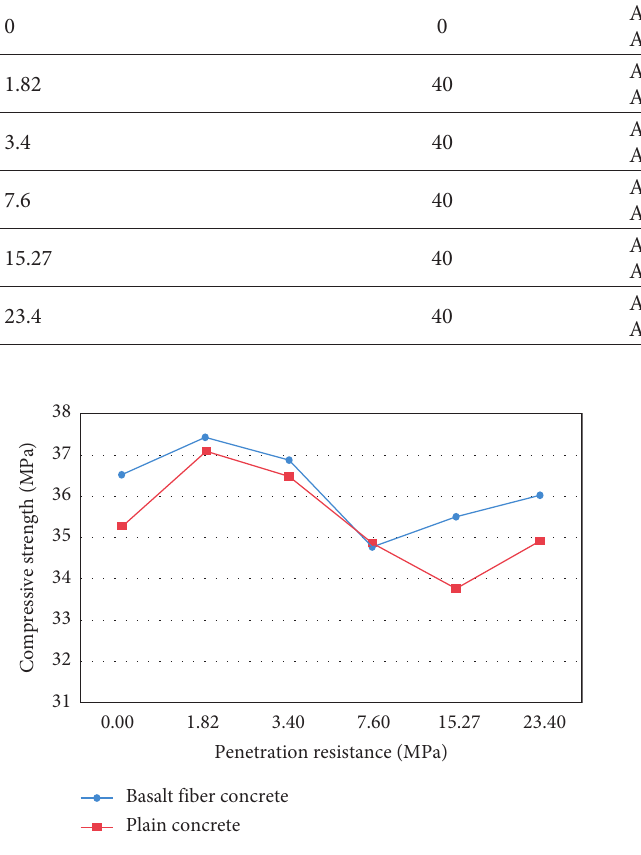
Figure 4: Comparison of compressive strength of plain concrete and of basalt fiber